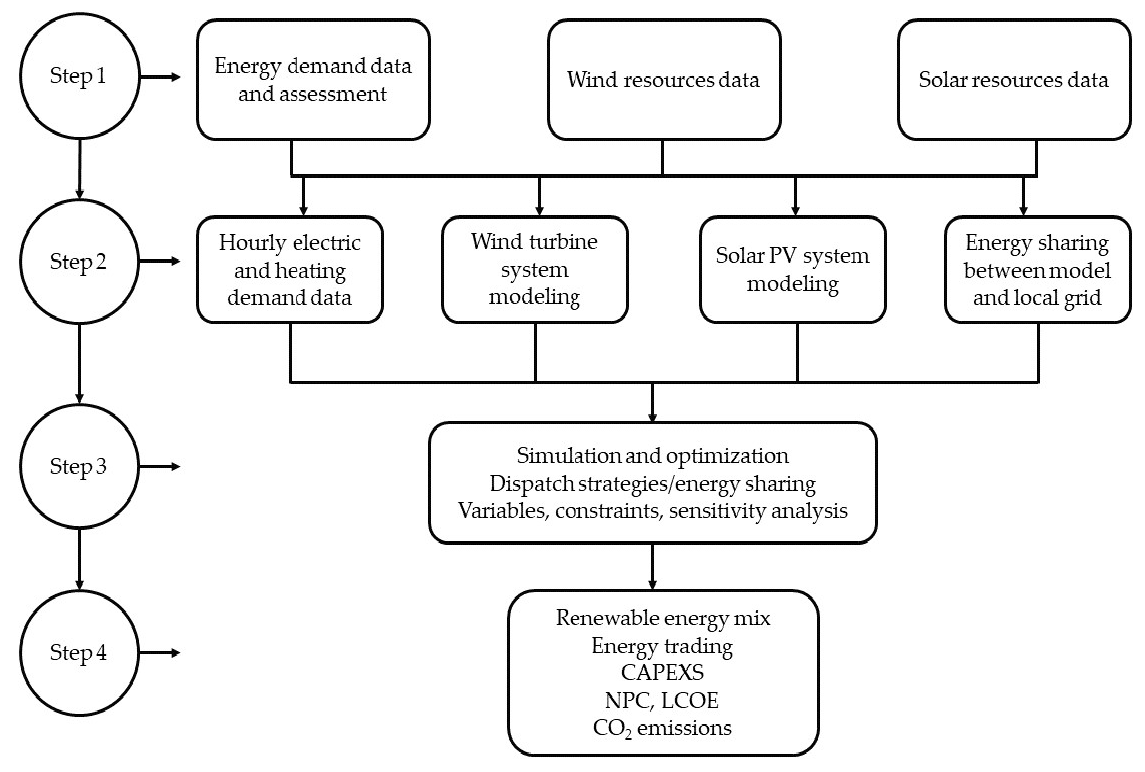
Figure 1. Process flowchart of the developed energy system model.